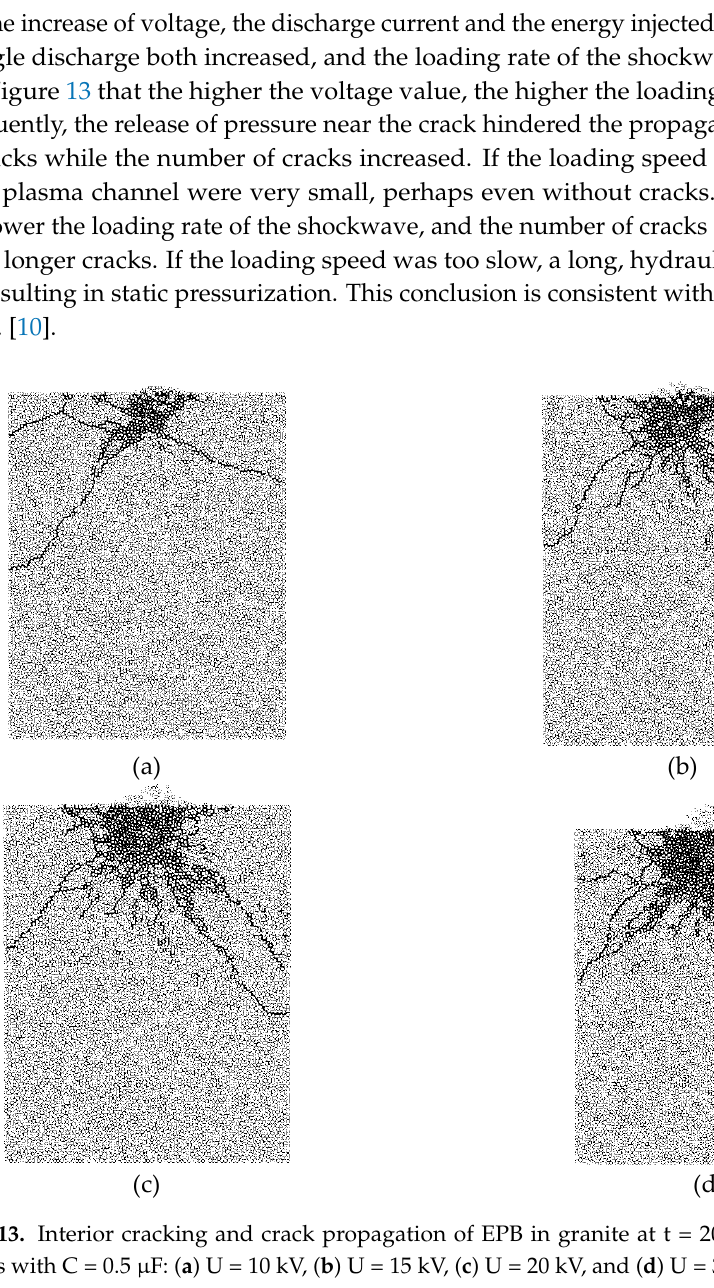
Figure 12. Interior cracking and crack propagation of EPB in granite, C = 0.5 μF, L = 5μH, U = 15kV: ( a ) t = 80μs, ( b ) t = 100 μs, ( c ) t = 200 μs, and ( d ) t = 400 μs.